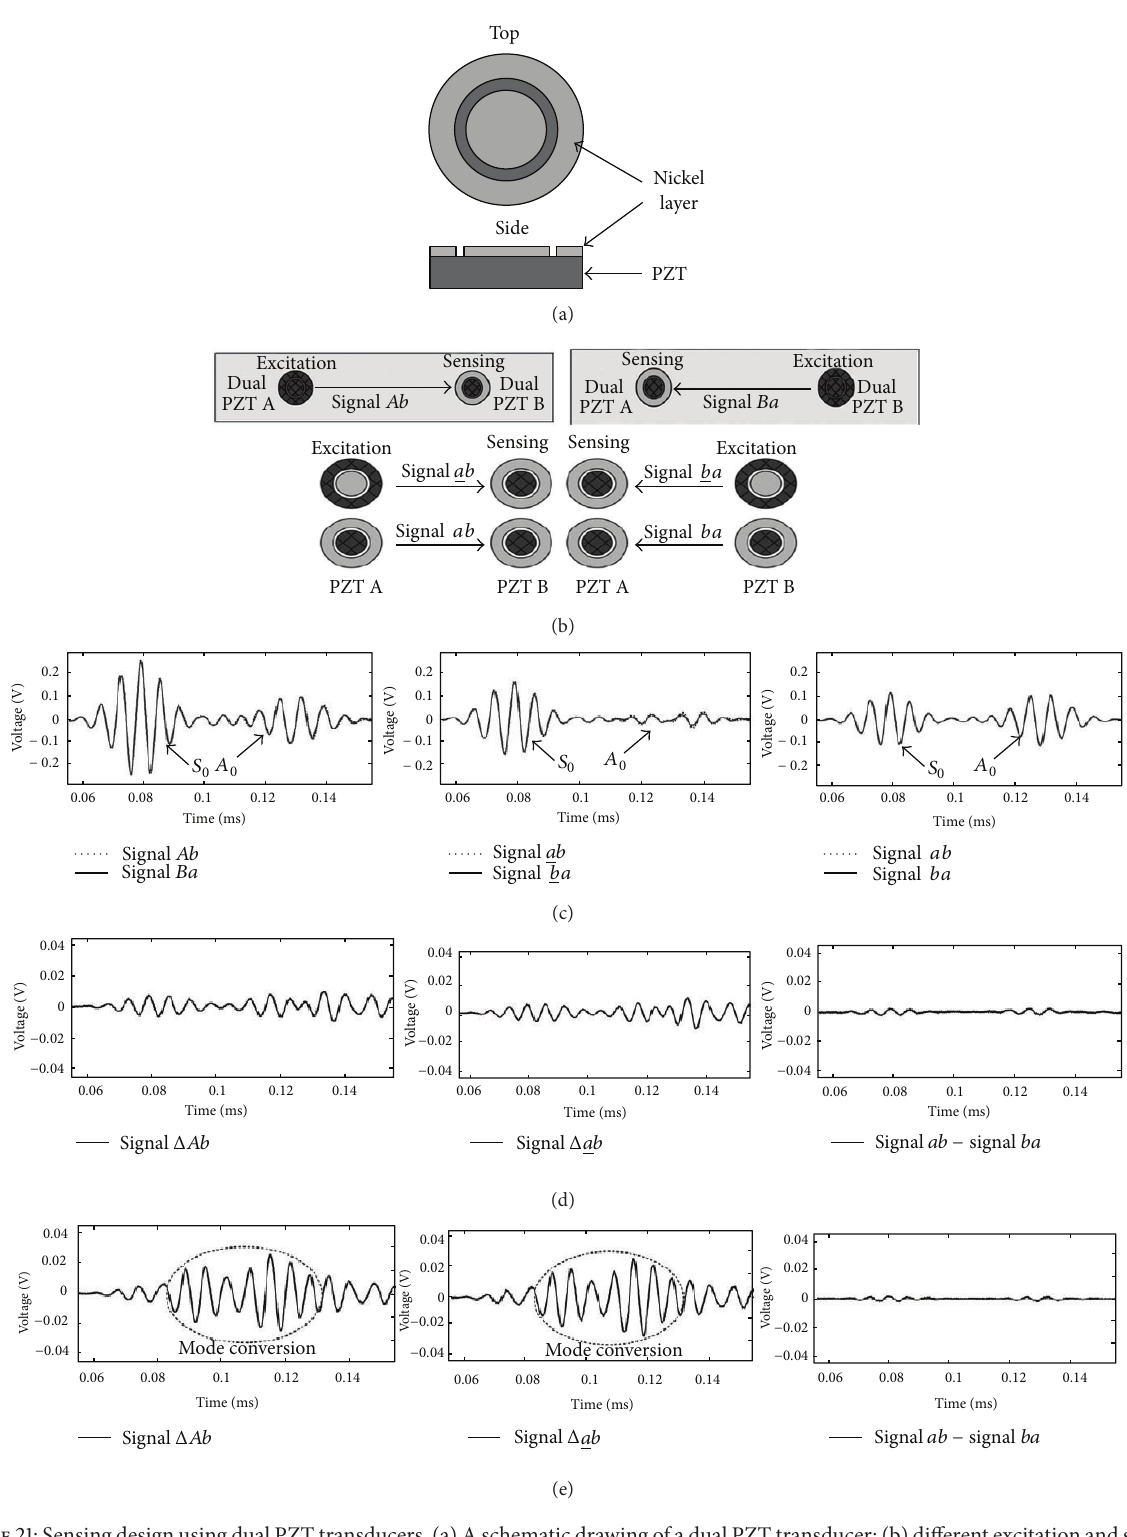
Figure 21: Sensing design using dual PZT transducers. (a) A schematic drawing of a dual PZT transducer; (b) different excitation and sensing combinations; (c) signals measured with sensing configurations illustrated in (b); (d) difference between signal pairs in each of the panes of (c); (e) corresponding signal differences of those illustrated in the panes of (d) but with introduction of a notch in the